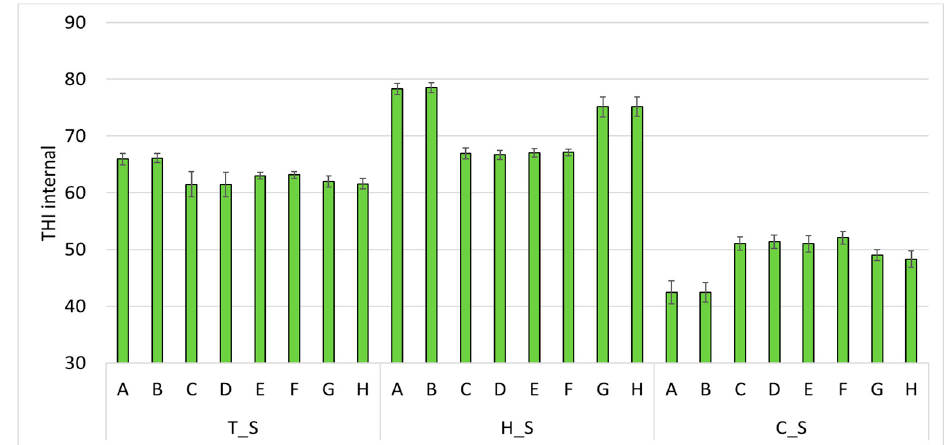
Figure 2. Average daily THI in every farm (A to H) during the three measuring periods (thermoneutral = T_S, hot = H_S and cold = C_S). Vertical bars express the standard deviation.